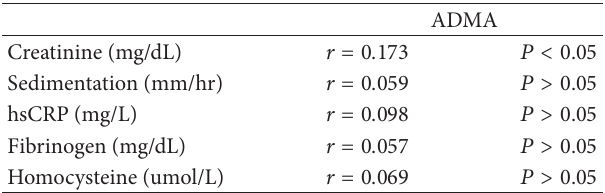
Table 4: Correlations between ADMA and creatinine, sedimenta- tion, hsCRP, fibrinogen, and homocysteine in MVD group.